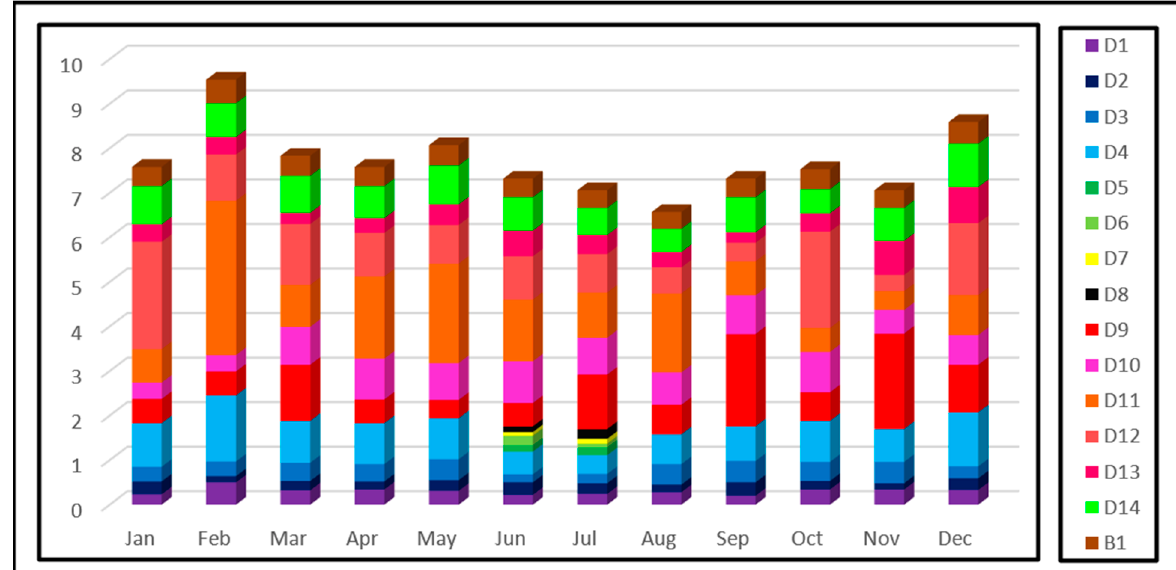
Figure 9. Groundwater pumped to study area (MCM).